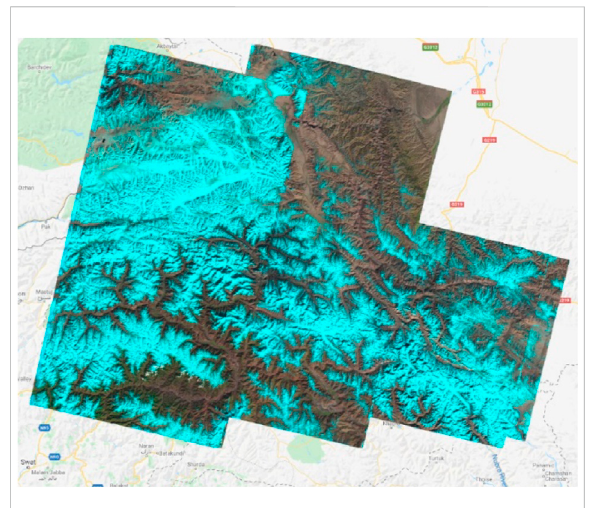
FIGURE 2 Mosaiced image with 10 scenes in Google Earth Engine (GEE) with false color composite and less than 10% cloud cover over the study